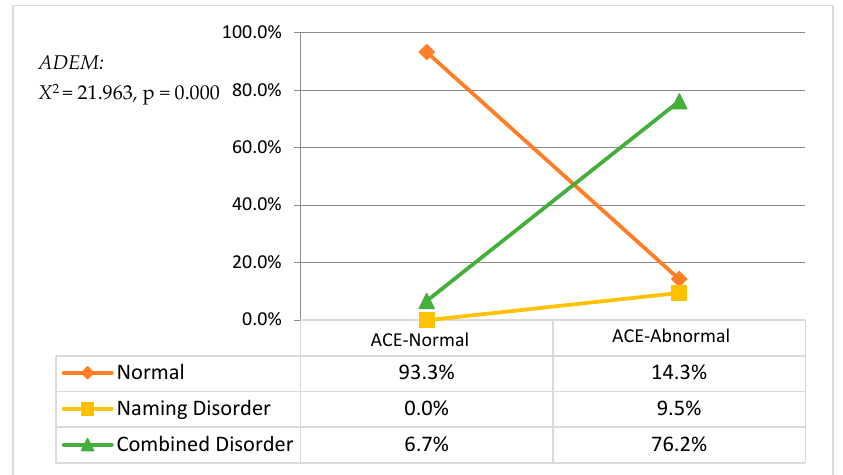
Figure 2. ADEM types between ACE-normal and -abnormal subjects.